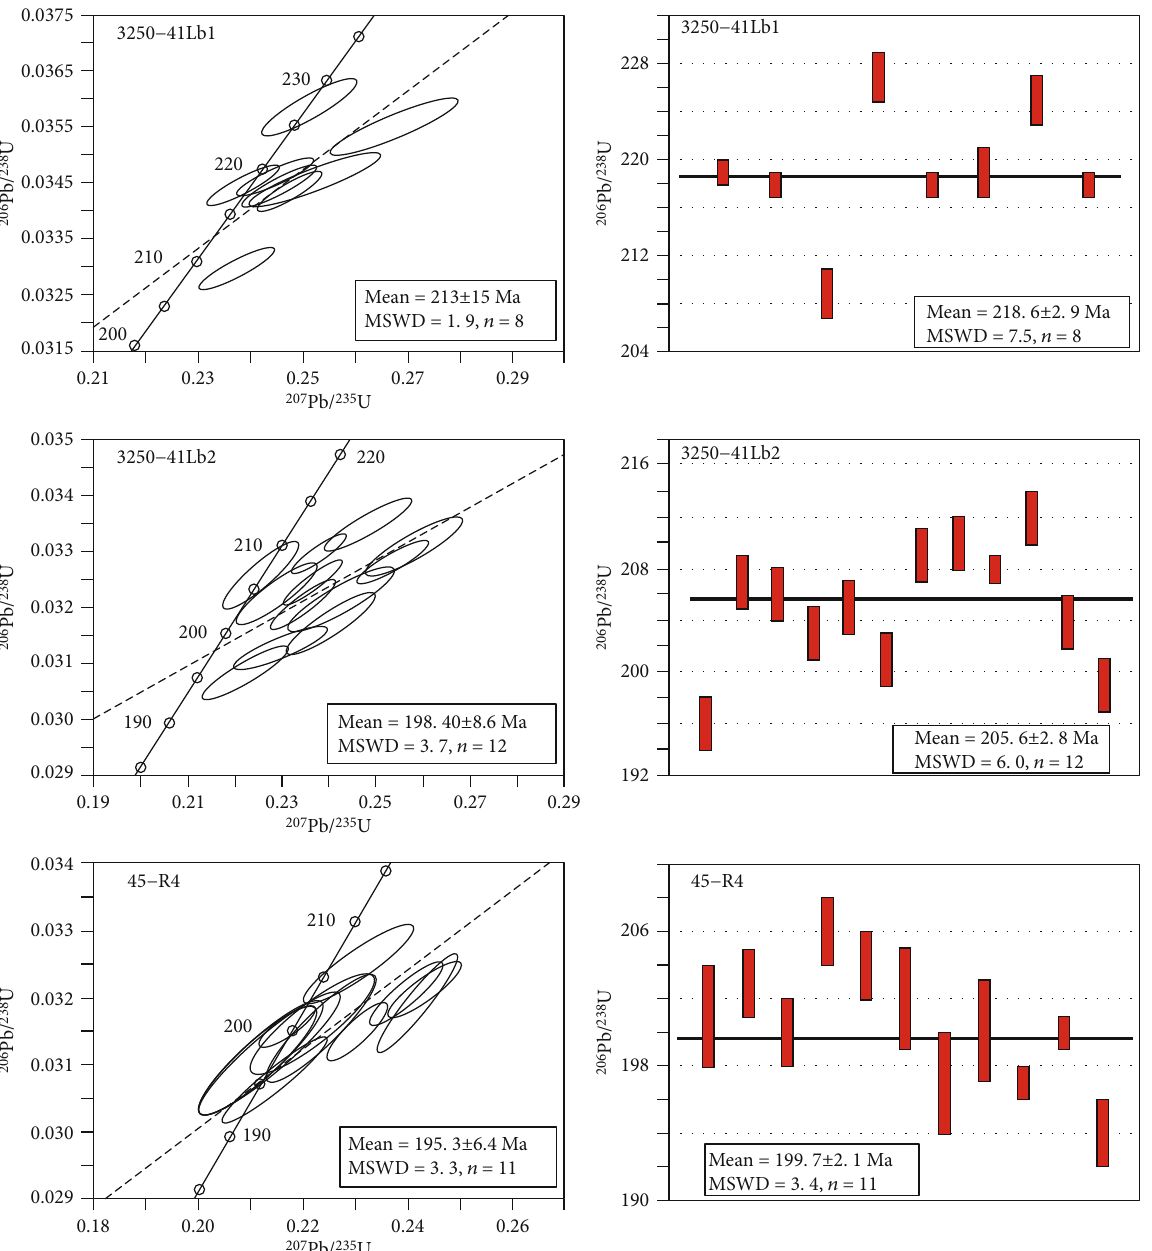
Figure 10: LA-ICP-MS zircon U-Pb concordia diagram of the granite porphyries in Yangla copper deposit, Yunnan,